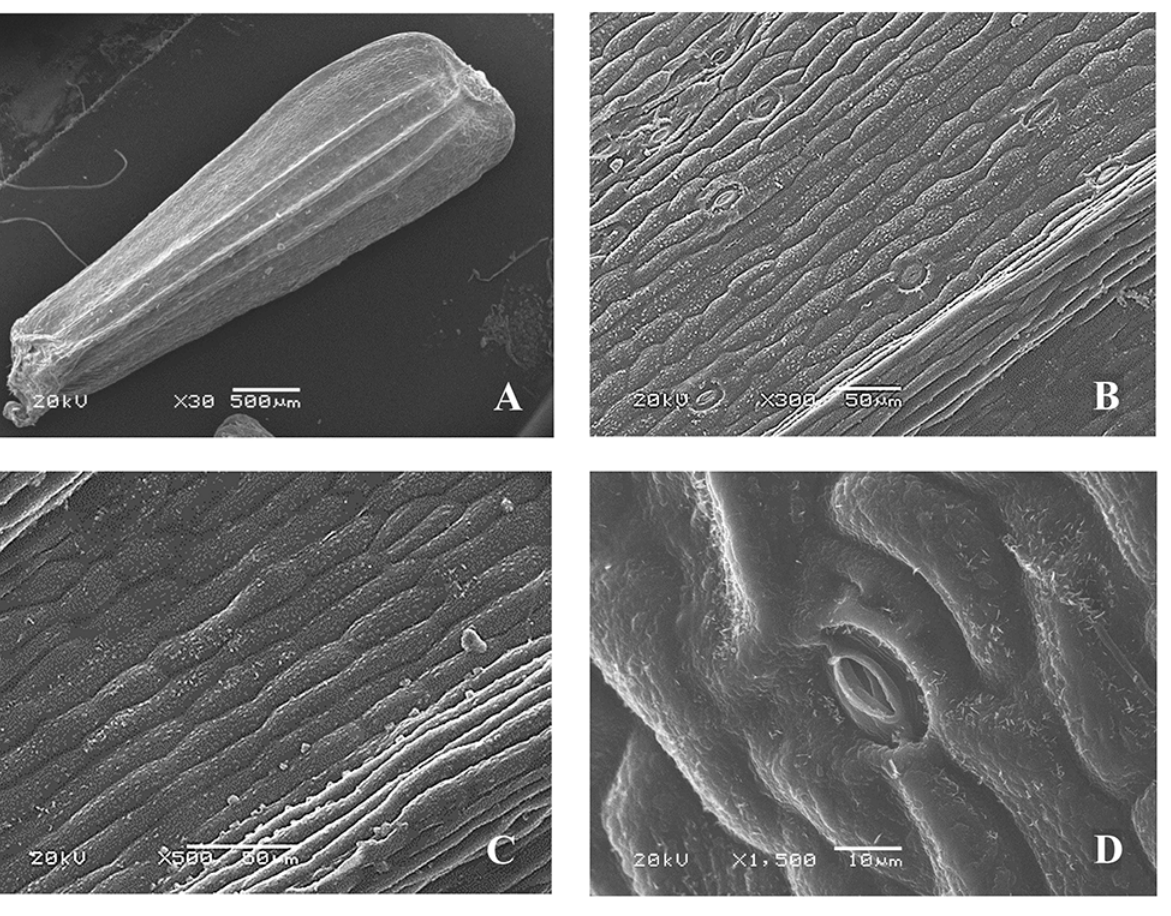
Figure 8 Fruit of Valeriana sambucifolia J. C. Mikan (SEM): General view ( A ); fragment of the fruit surface ( B,C ); stomium ( D